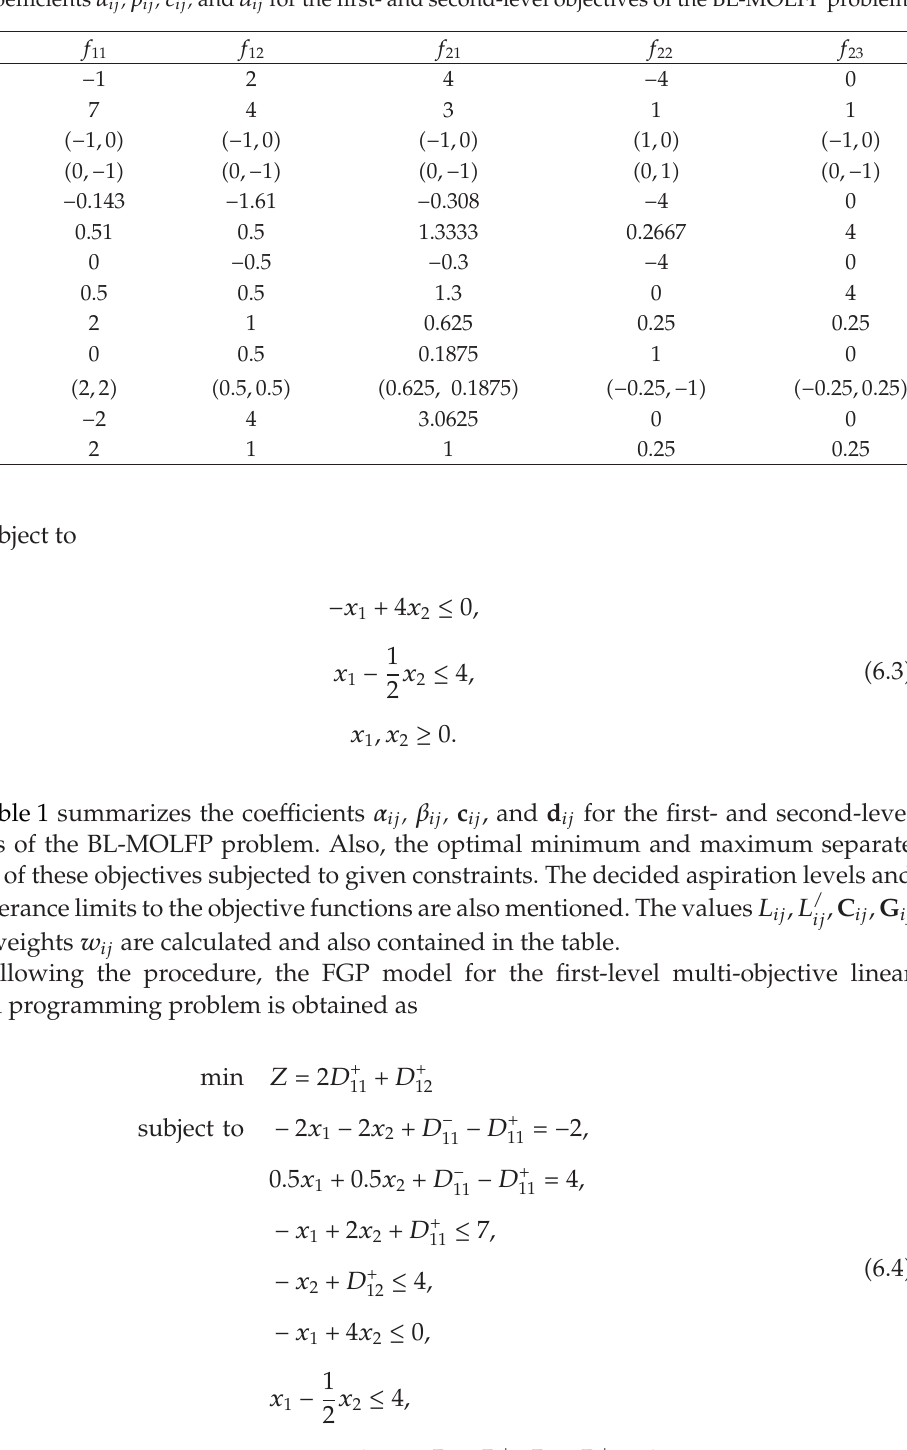
Table 1: Coe ffi cients α ij , β ij , c ij , and d ij for the first- and second-level objectives of the BL-MOLFP